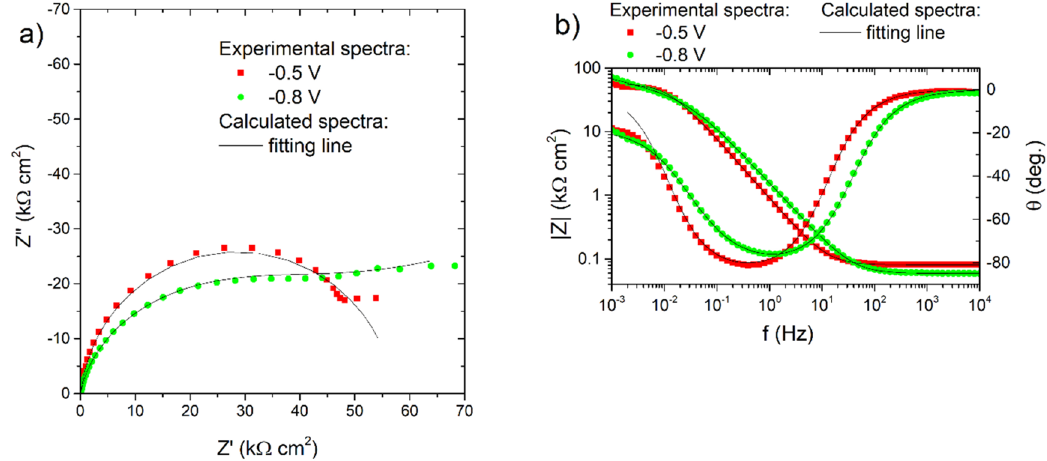
Figure 12. Nyquist ( a ) and Bode ( b ) graphs for the impedance spectra of selected Ni–Mo coatings recorded at E